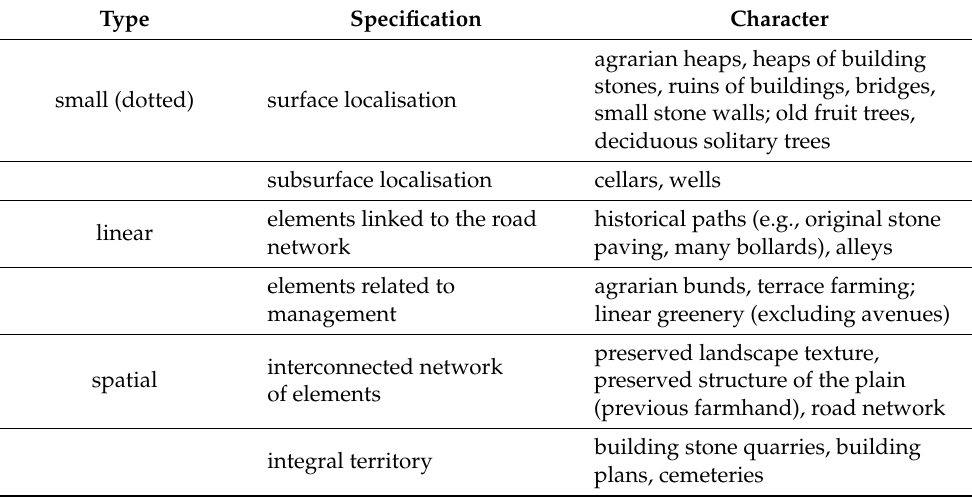
agrarian heaps, heaps of building stones, ruins of buildings, bridges, small stone walls; old fruit trees, deciduous solitary trees historical paths (e.g., original stone paving, many bollards), alleys agrarian bunds, terrace farming; linear greenery (excluding avenues) preserved landscape texture, preserved structure of the plain (previous farmhand), road network plans,